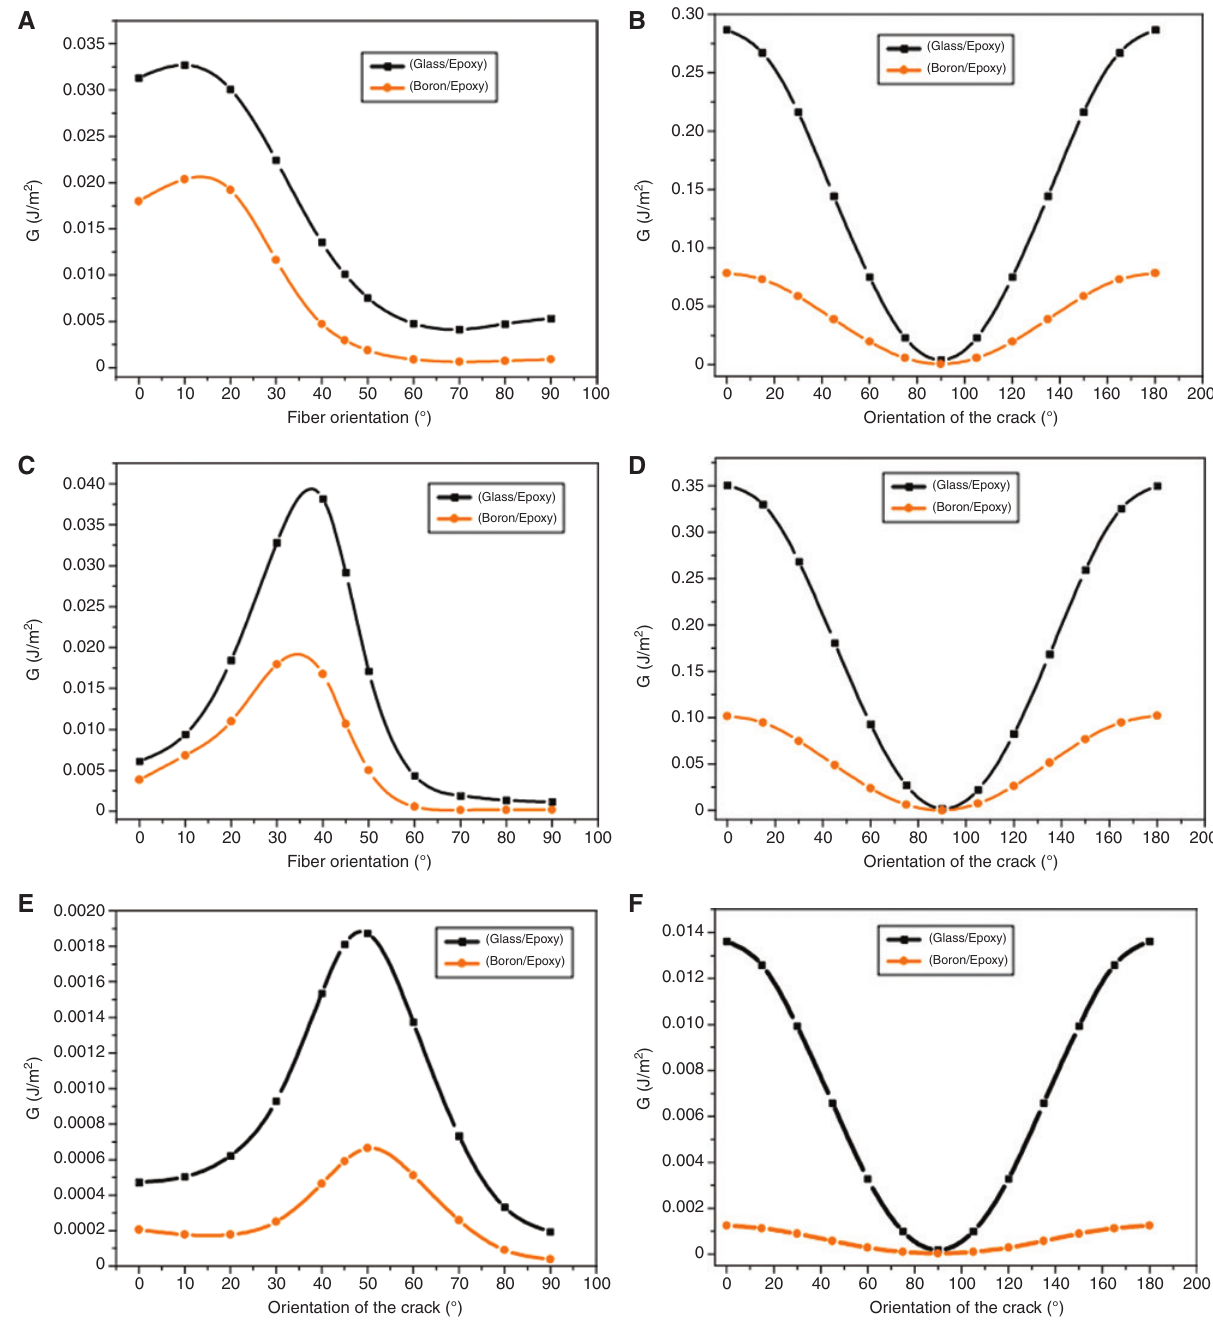
Figure 15: Variation in the rate of energy restitution of the two materials. (A) α is variable, β = 70 ° and γ = 0 ° . (B) α = 90 ° β is variable and γ = 0 ° . (C) α is variable, β = 70 ° and γ = 45 ° . (D) α = 90 ° β is variable and γ = 45 ° . (E) α is variable, β = 90 ° and γ = 90 ° . (F) α = 90 ° β is variable and γ = 90 °